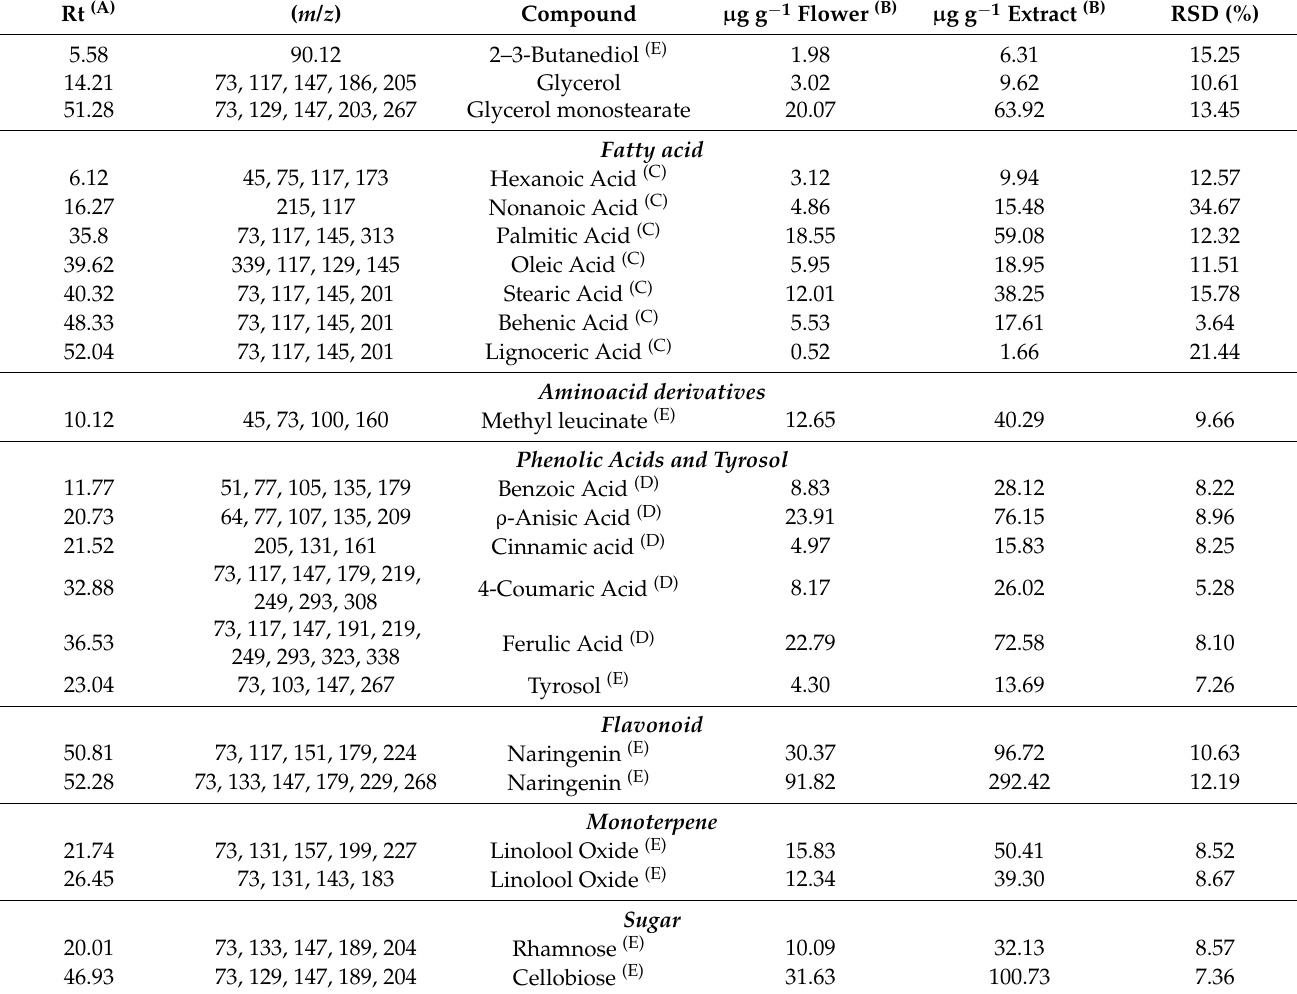
Table 1. Composition of S. nigra flower dichloromethane extract with the respective relative standard deviation (RSD). Rt